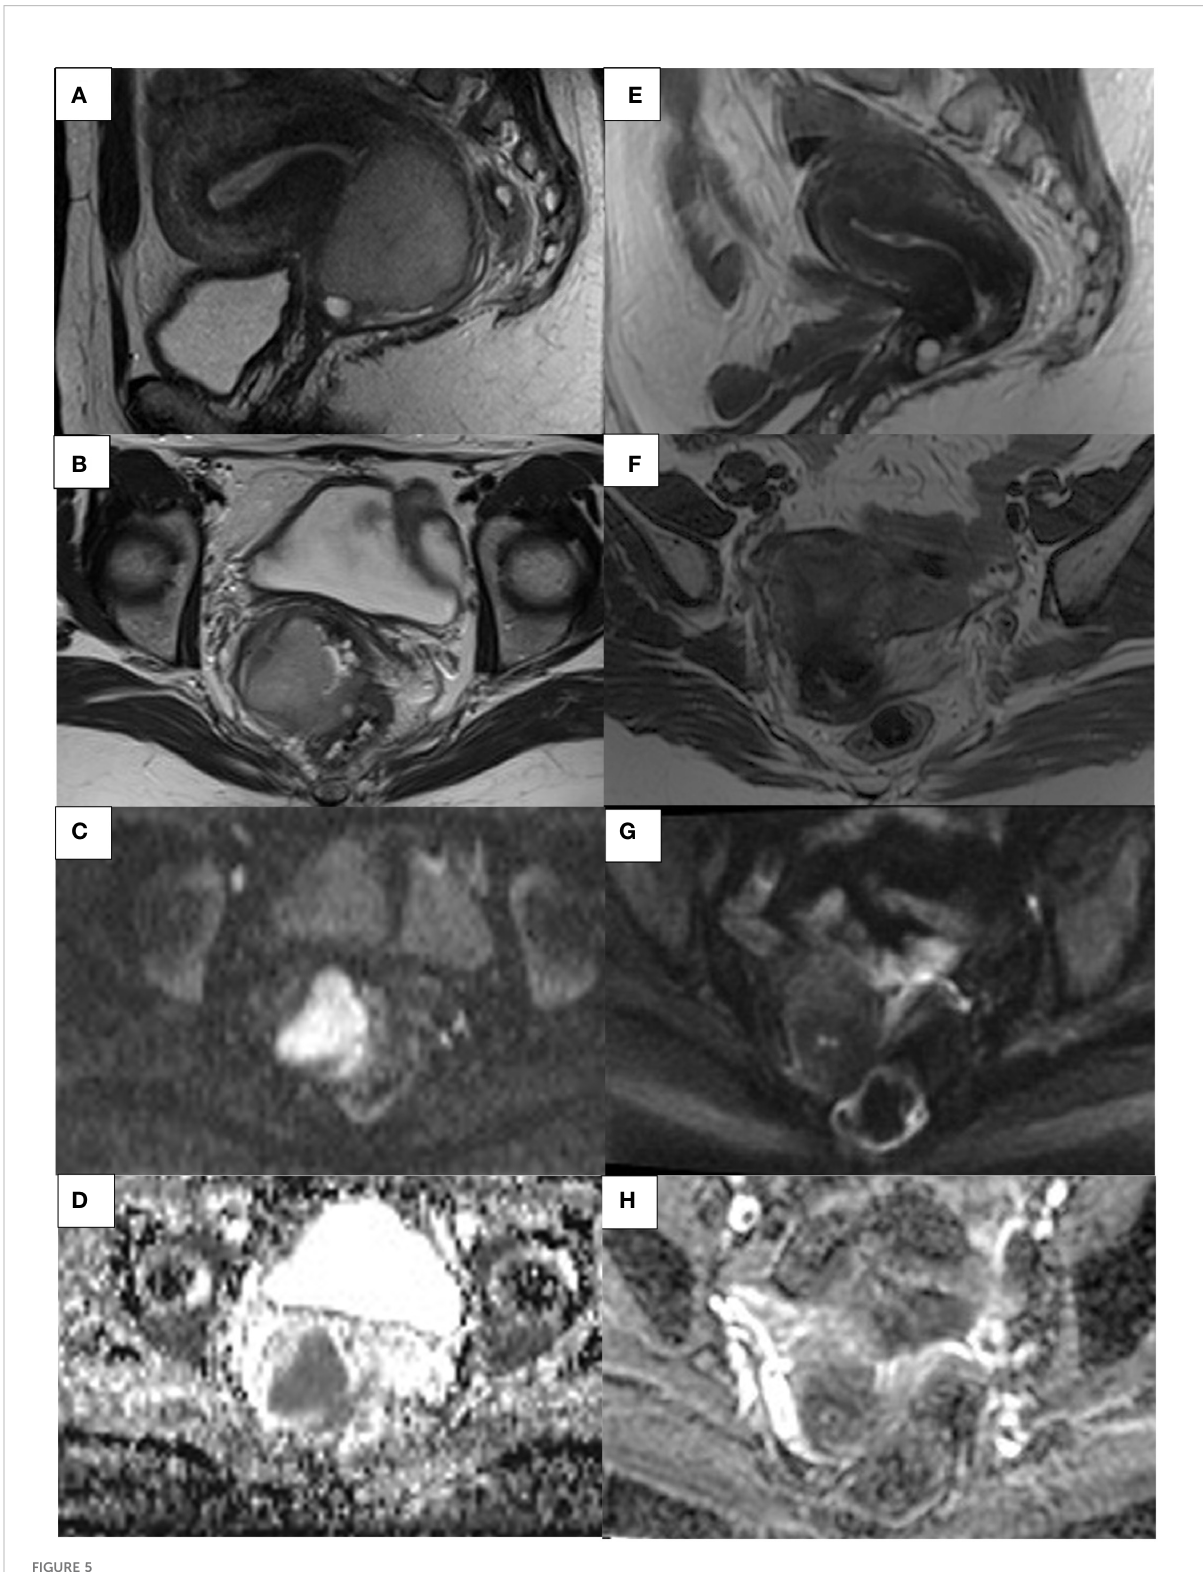
FIGURE 5 41- year-old woman. Sagittal and axial T2W (A, B) and axial DWI MR images with ADC map (C, D) show an invasive CC extending to the upper third of the vaginal canal and anterior rectal wall with focal parametrial in fi ltrations. Sagittal and axial T2W (E, F) and axial DWI MRI images with ADC map (G, H) shows a complete response after